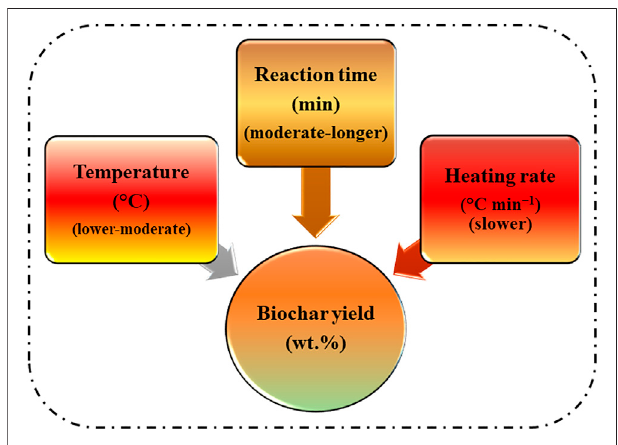
FIGURE 6 | Favorable pyrolysis conditions to obtain highest biochar yield through slow